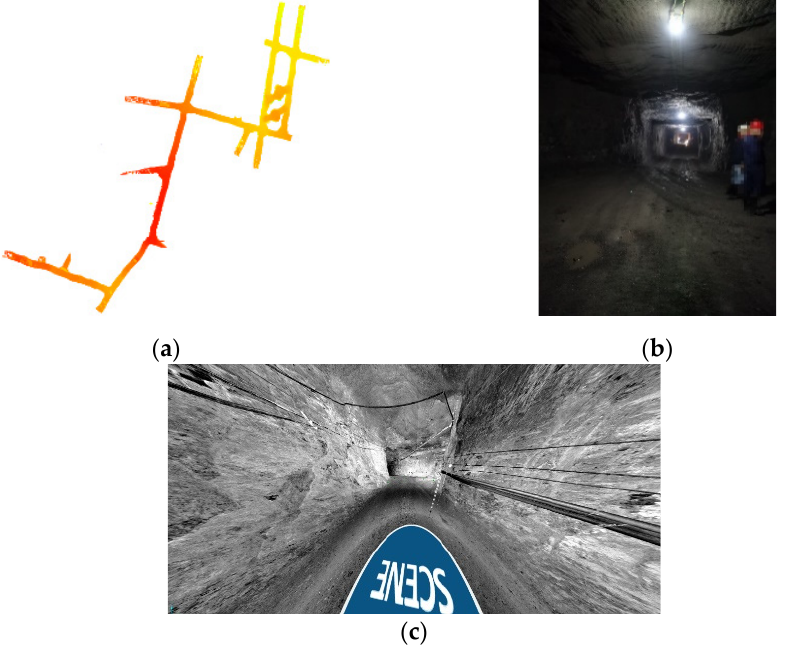
Figure 10. ( a ) is a pre-built point cloud map; ( b ) is a picture of a real underground